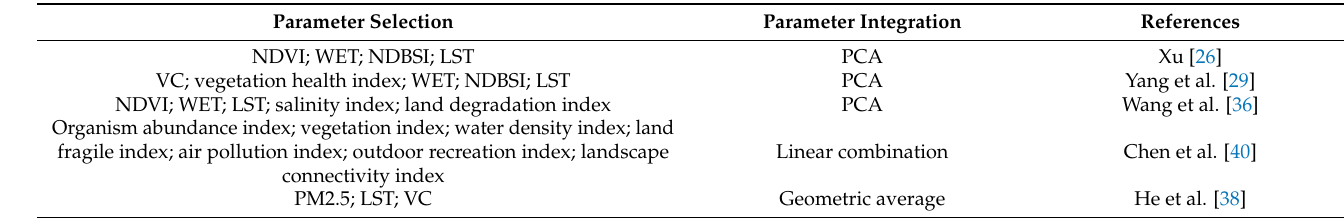
Table 1. Representative studies of ecological assessment based on multiple remotely sensed